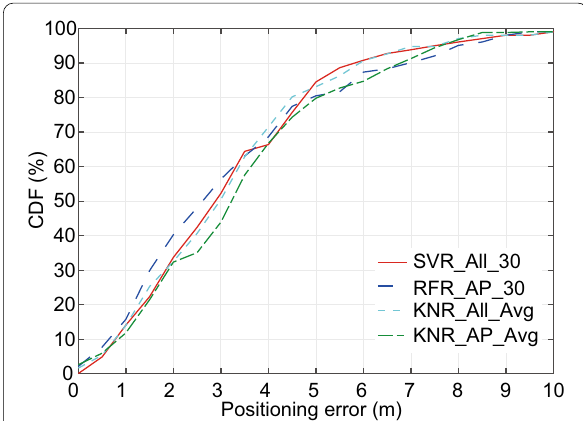
Fig. 6 Positioning errors of several regression methods based on the four training sheets containing different MACs and samples in the SYL building